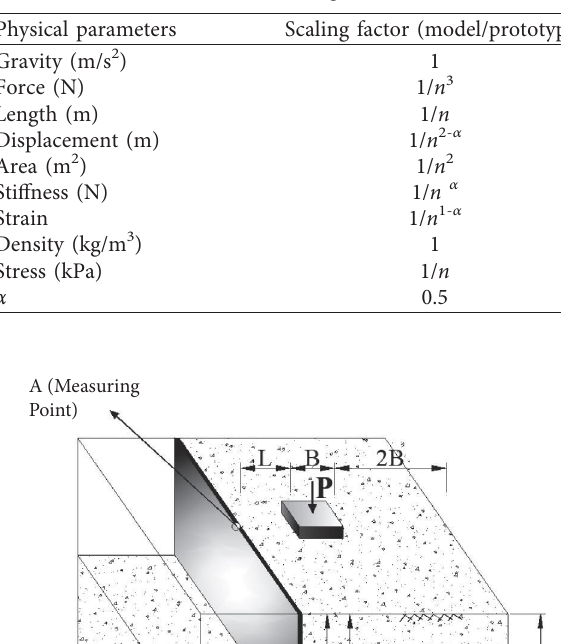
Table 3: Scaling laws.